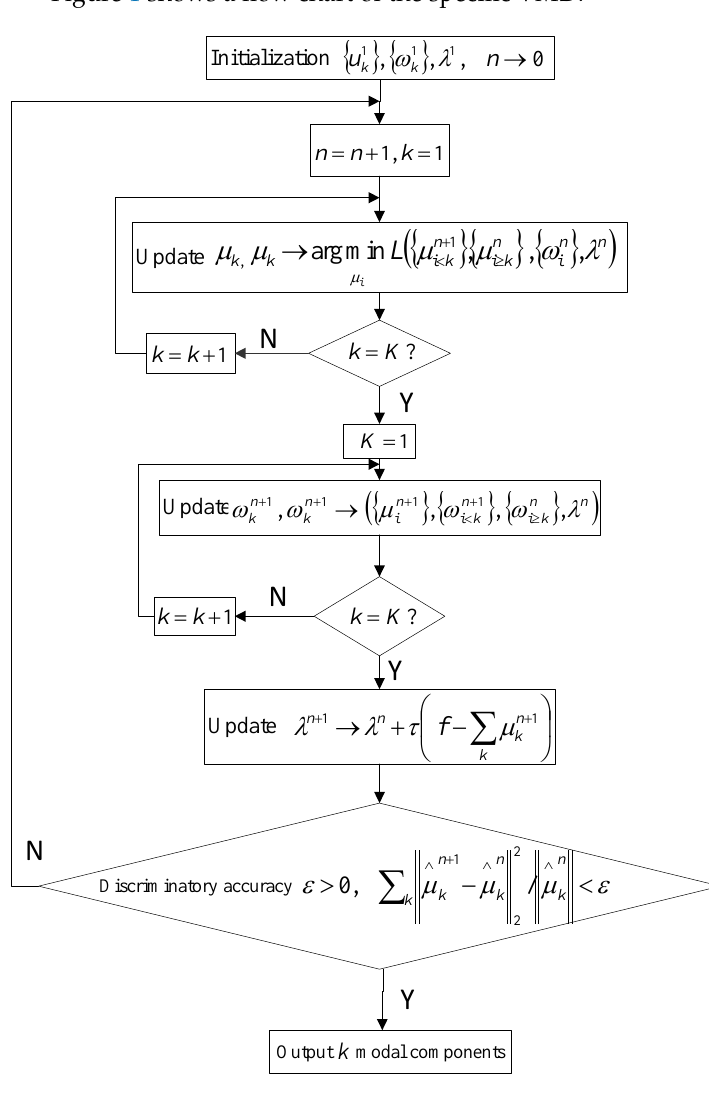
Figure 1. Flow chart of the specific VMD.